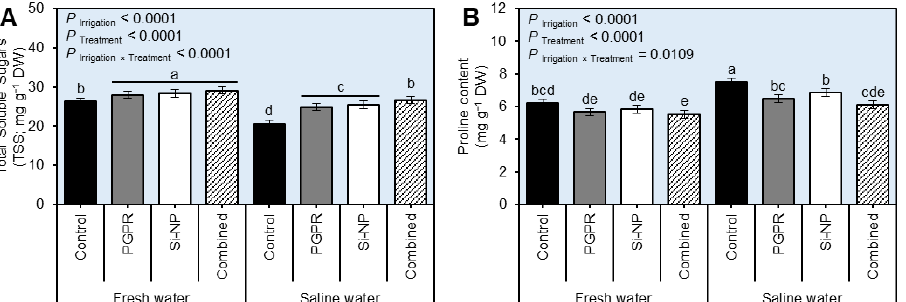
Figure 3. Effect of seed inoculation with PGPR and/or Si-NP foliar application on the biochemical response of sugar beet plants grown in salt-affected soil and subjected to saline water irrigation during the 2019/2020 seasons. ( A ) Total soluble sugars (TSS; mg g − 1 DW), and ( B ) proline content (mg g − 1 DW) during the 2019/2020 seasons, respectively. Data presented are the means ± standard deviation (mean ± SD) of three biological replicates. Different letters signify statistically significant differences between treatments according to Tukey’s HSD test ( P Irrigation × Treatment ≤ 0.05).